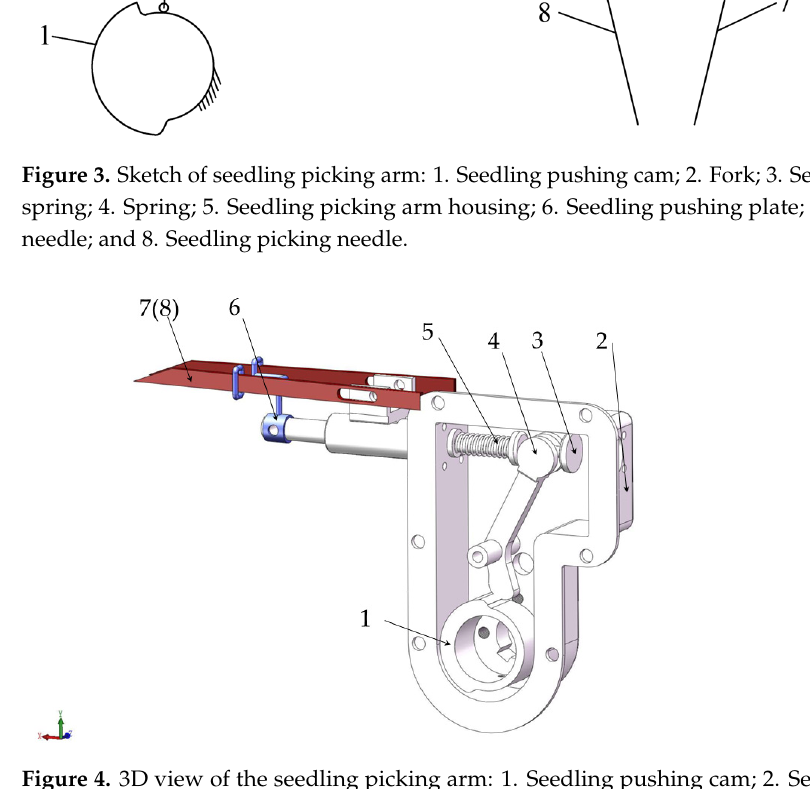
Figure 4. 3D view of the seedling picking arm: 1. Seedling pushing cam; 2. Seedling picking arm housing; 3. Seedling pushing rod; 4. Folk; 5. Spring; 6. Seedling pushing plate; 7. Seedling picking needle; and 8. Seedling picking needle.